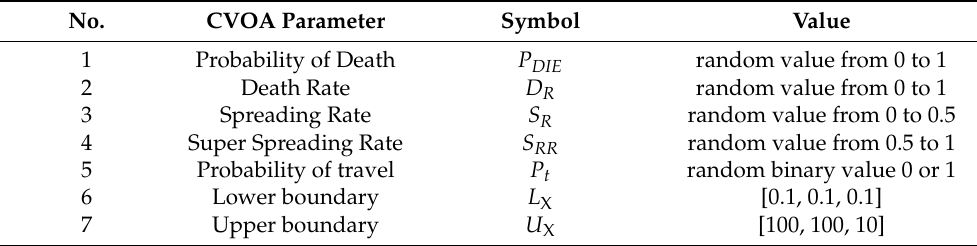
Table 2. The CVOA